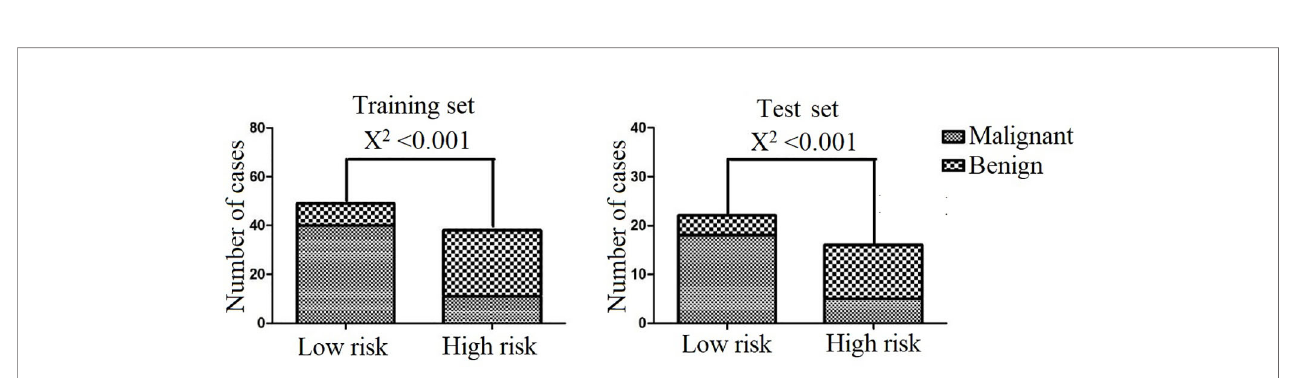
FIGURE 7 | Classi fi cation performance of the combined model in the training and test